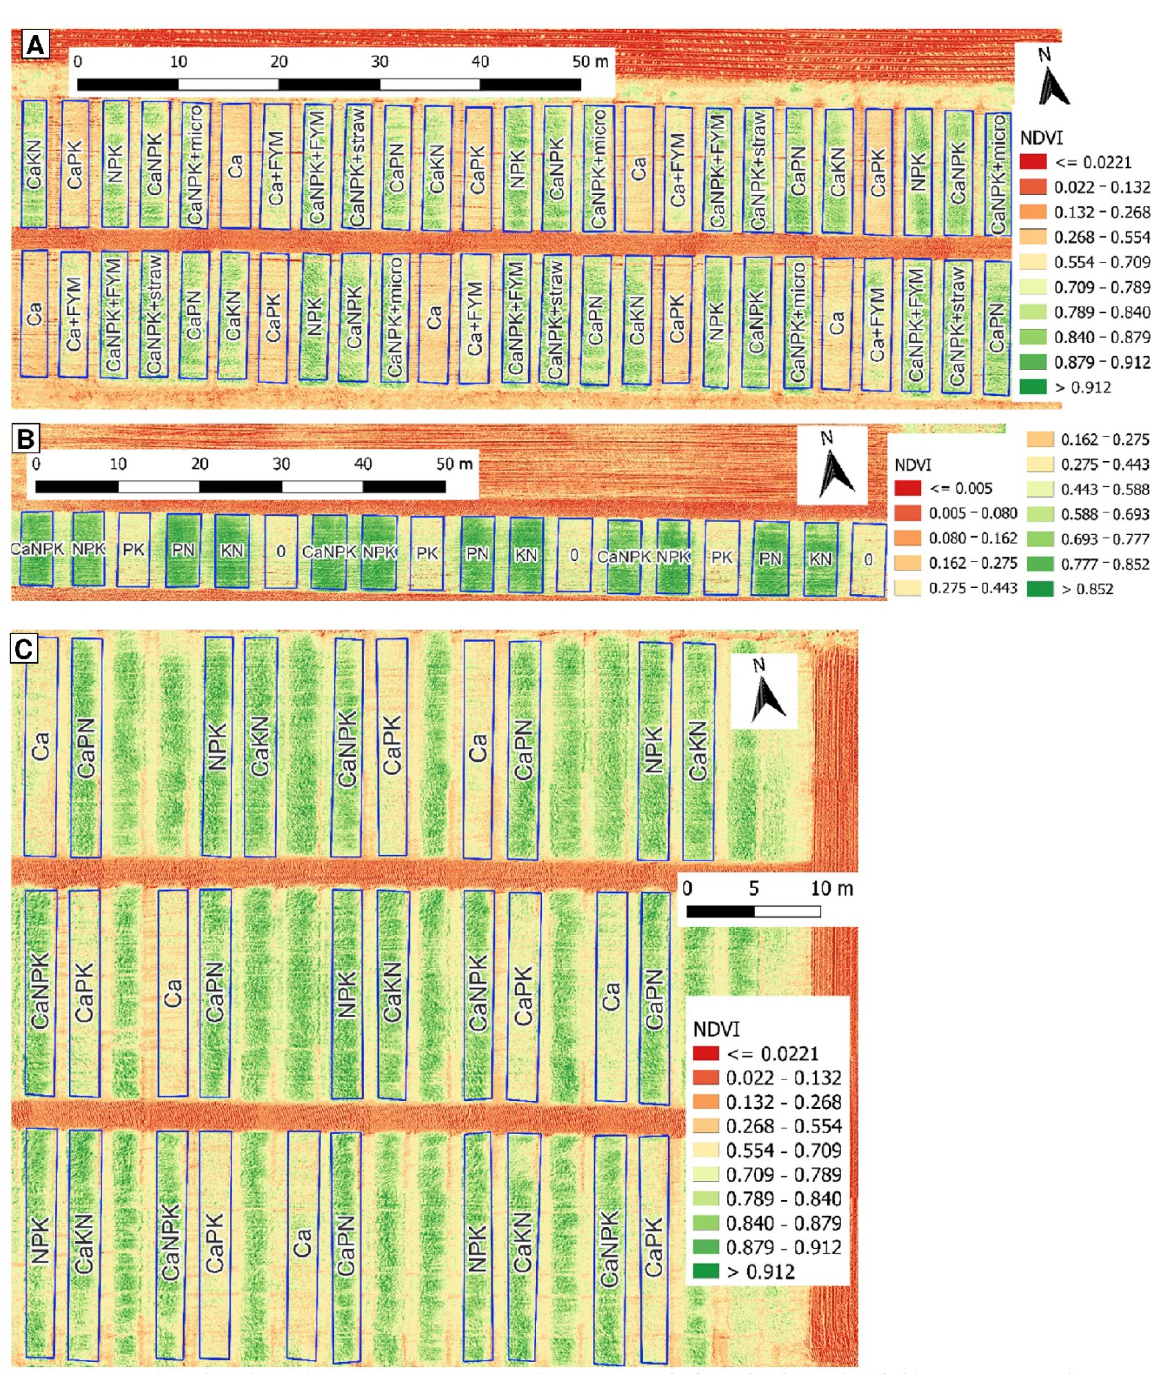
Figure 2. NDVI based on the multispectral images acquired by UAV on 3 June 2022, for the studied field experiments at the Experimental Station in Skierniewice. ( A )—field experiment 2; ( B )—field